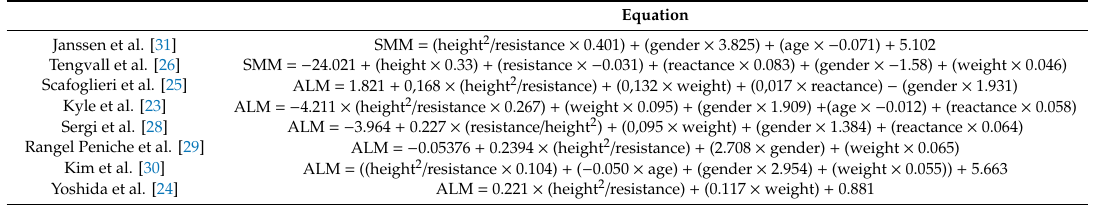
Table 2. Tested bioimpedance equations for muscle